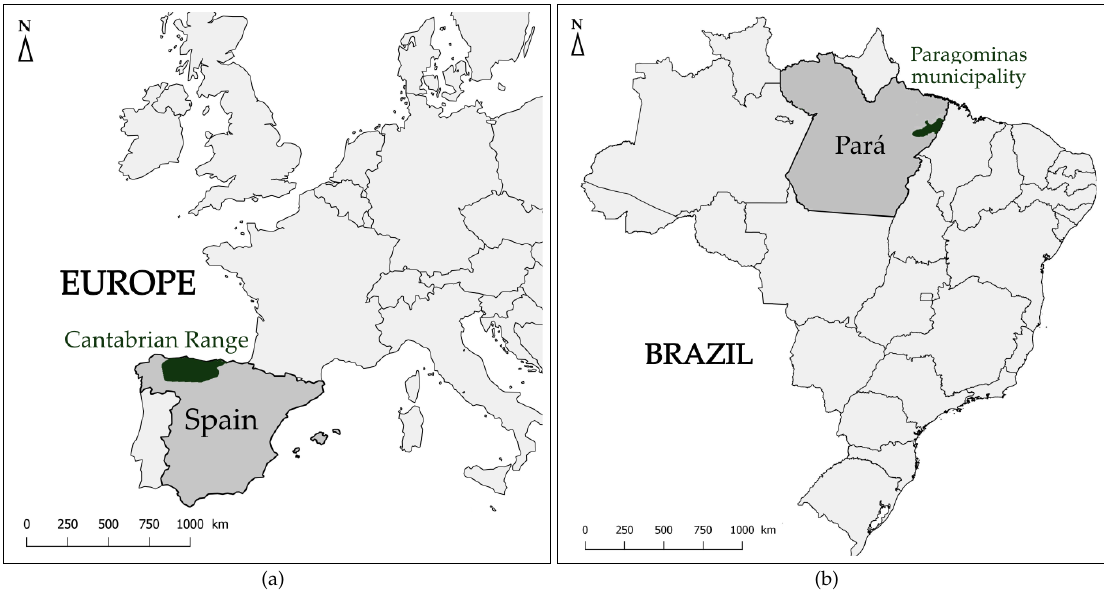
Figure 1. Location of ( a ) the Spanish study area ( c (cid:13) EuroGeographics for the country boundaries) and ( b ) the Brazilian study area ( c (cid:13) 2018 GADM for the state